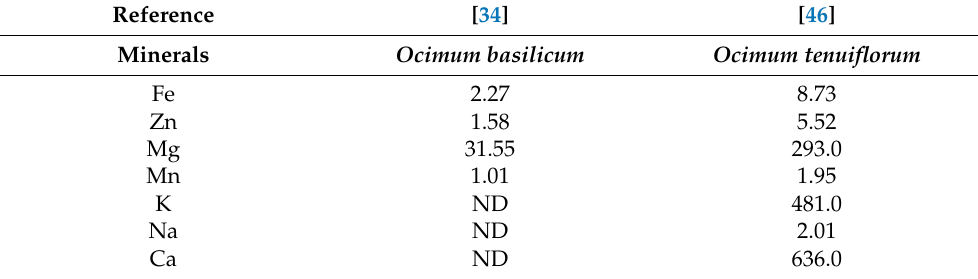
Table 5. The mineral composition of basil seeds (mg/100